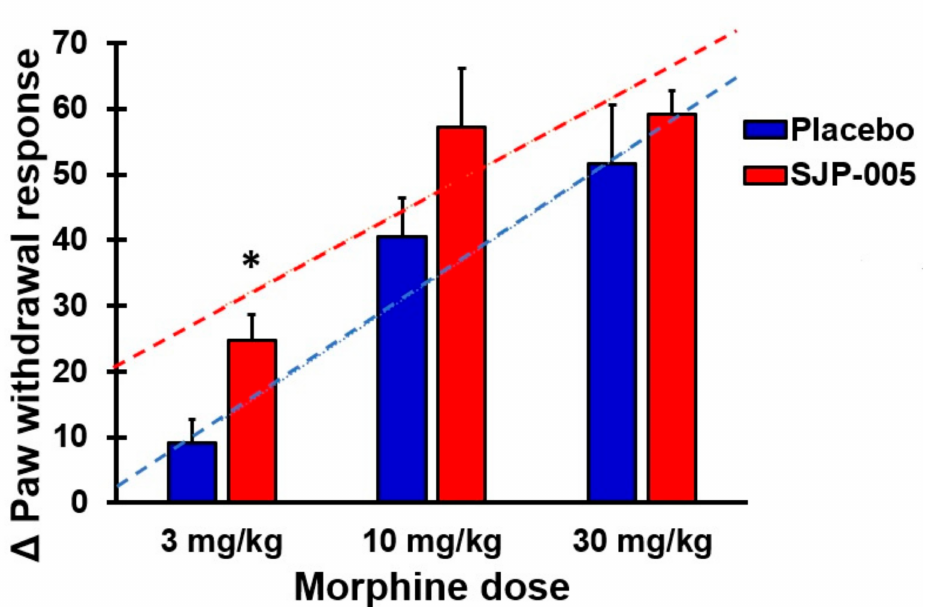
Figure 1. Paw withdrawal response (pre–post difference scores) after SJP-005 or placebo. The mean difference scores between post- and pre-dose assessments are shown. Error bars represent the standard error of the mean. Significant differences ( p < 0.05) are indicated with *. Dashed lines represent the best-fitting linear trend lines for the dose–response relationship of morphine + placebo (blue color) and morphine + SJP-005 (red color). Each of the treatment groups consisted of 10